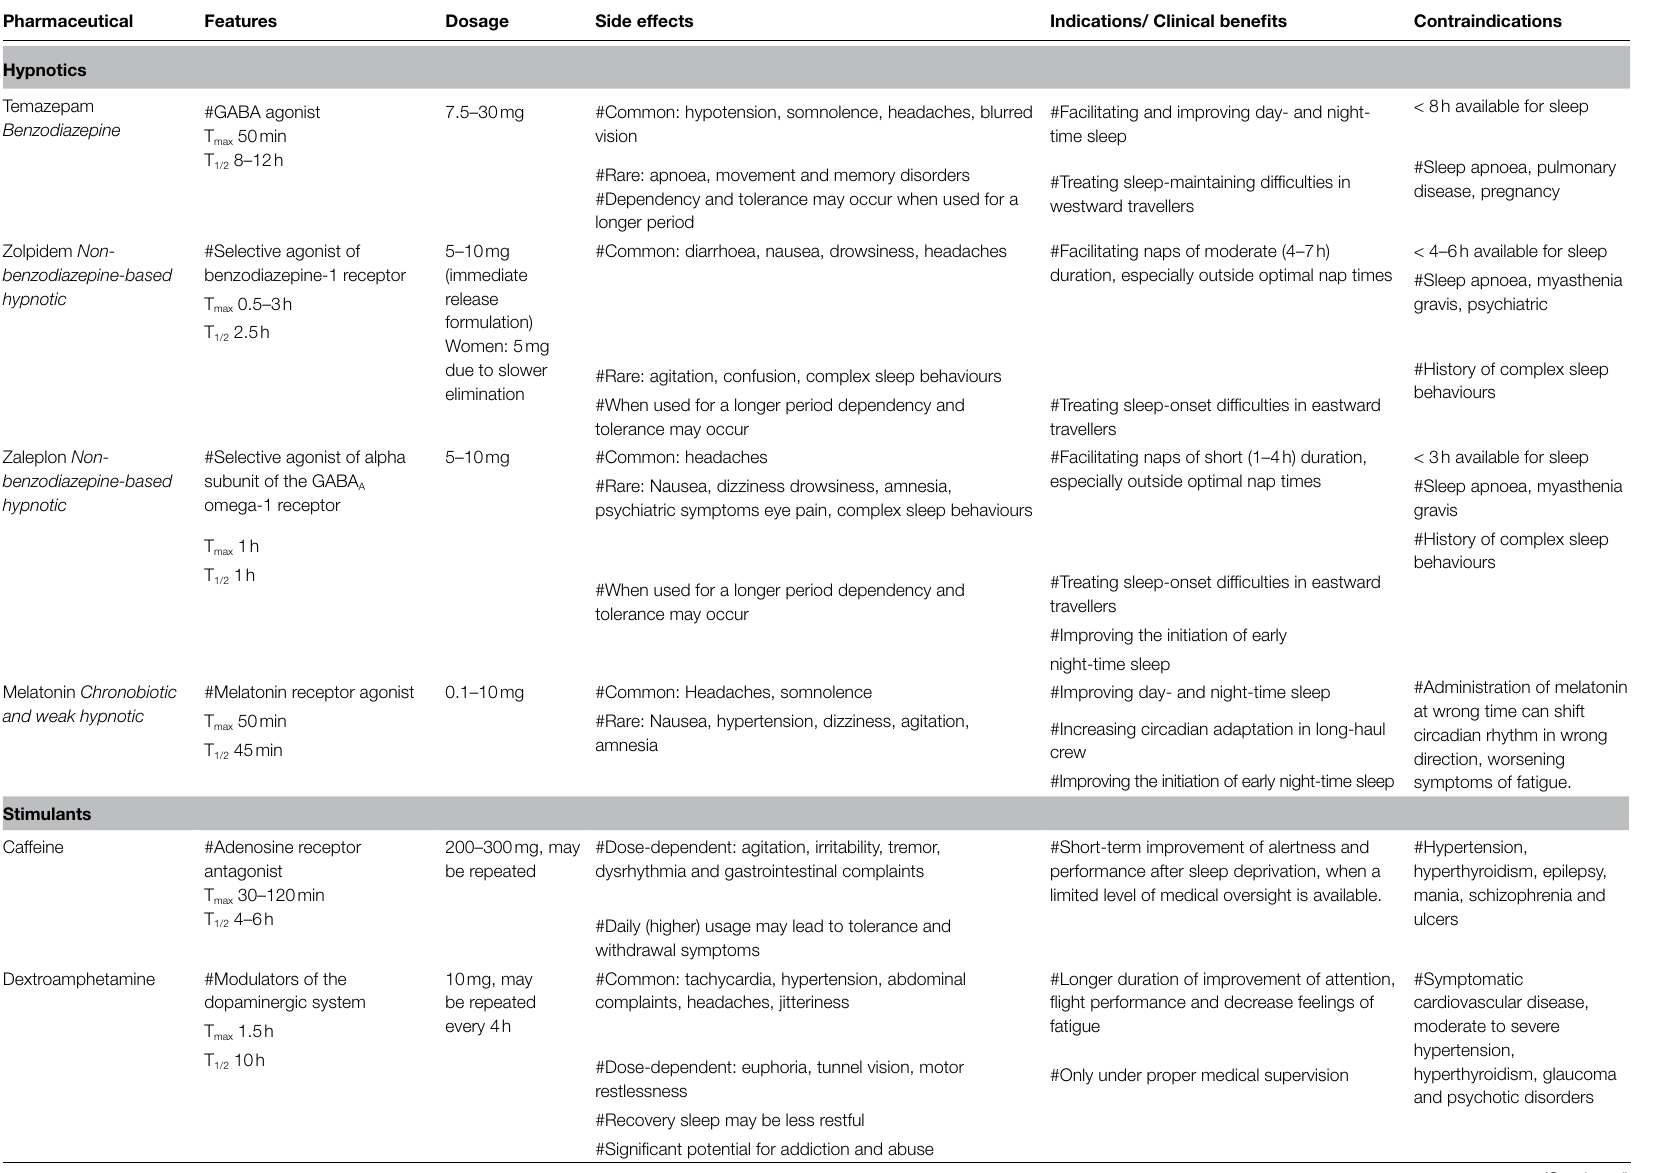
TABLE 1 | Pharmaceutical